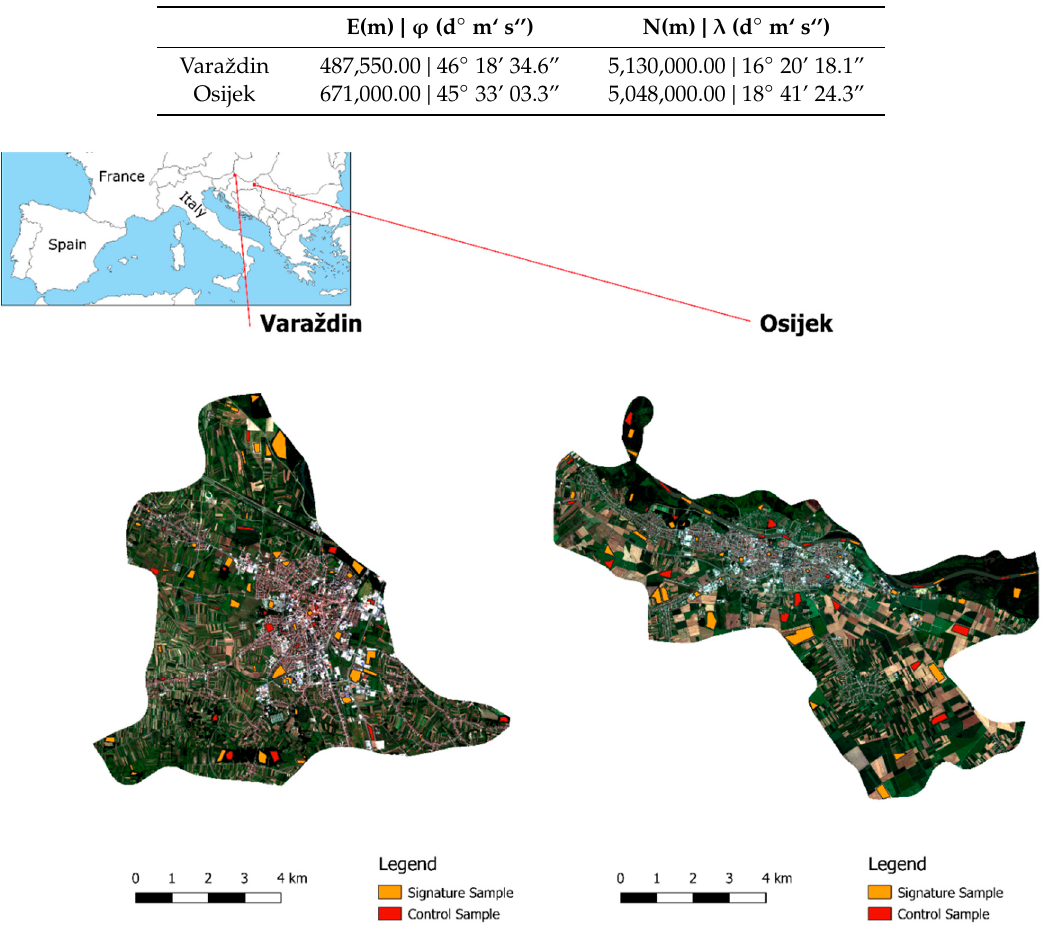
Figure 1. The study areas: Varaždin (left); Osijek (right) [15].